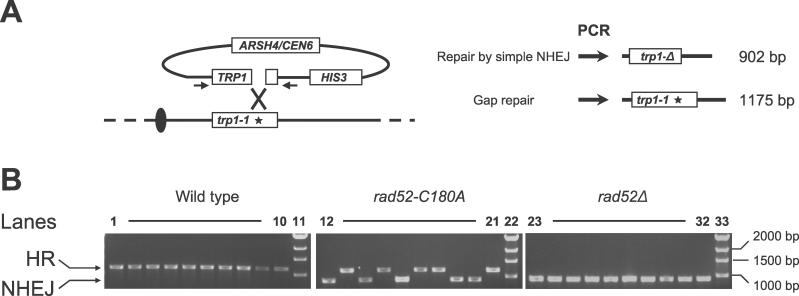
Gap Repair Is Impaired in rad52 Class C Mutant Strains(A) Graphical representation of the assay used to address the nature of gap closure events. Gapped pRS413-TRP1 repaired by HR. This event results in transfer of the trp1–1 mutation in the genome to the plasmid. The position of the trp1–1 mutation relative to the gapped TRP1 plasmid-borne sequence is indicated by an asterisk. Repair by simple NHEJ (without any further rearrangement/deletion of plasmid DNA) results in a 273-bp deletion in TRP1. The two types of events were distinguished by PCR using a plasmid specific primer pair, indicated as small arrows. The PCR product sizes expected from transformants resulting from a gapped plasmid that has been repaired by HR and from one that has been closed by NHEJ are shown.(B) Gel electrophoresis analysis of PCR fragments obtained from strains transformed with gapped pRS413-TRP1. Arrows point to the band sizes expected if the gapped plasmid has been repaired by HR or by NHEJ. Representative analyses of ten transformants obtained with wild-type strains (lanes 1–10), ten with rad52-C180A strains (lanes 12–21), and ten with rad52Δ strains (lanes 23–32). Sizes of relevant bands in the DNA marker (lane 11, 22, and 33) are indicated.